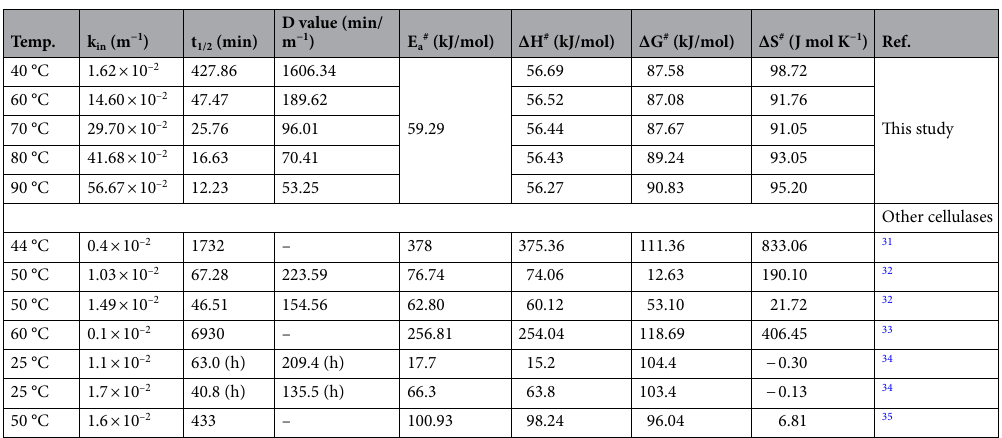
Table 7. Thermodynamic parameters for irreversible thermal inactivation of CelC307. The parameters were measured after 6 h incubation at various temperatures, and the values obtained at 40 °C compared with other studied